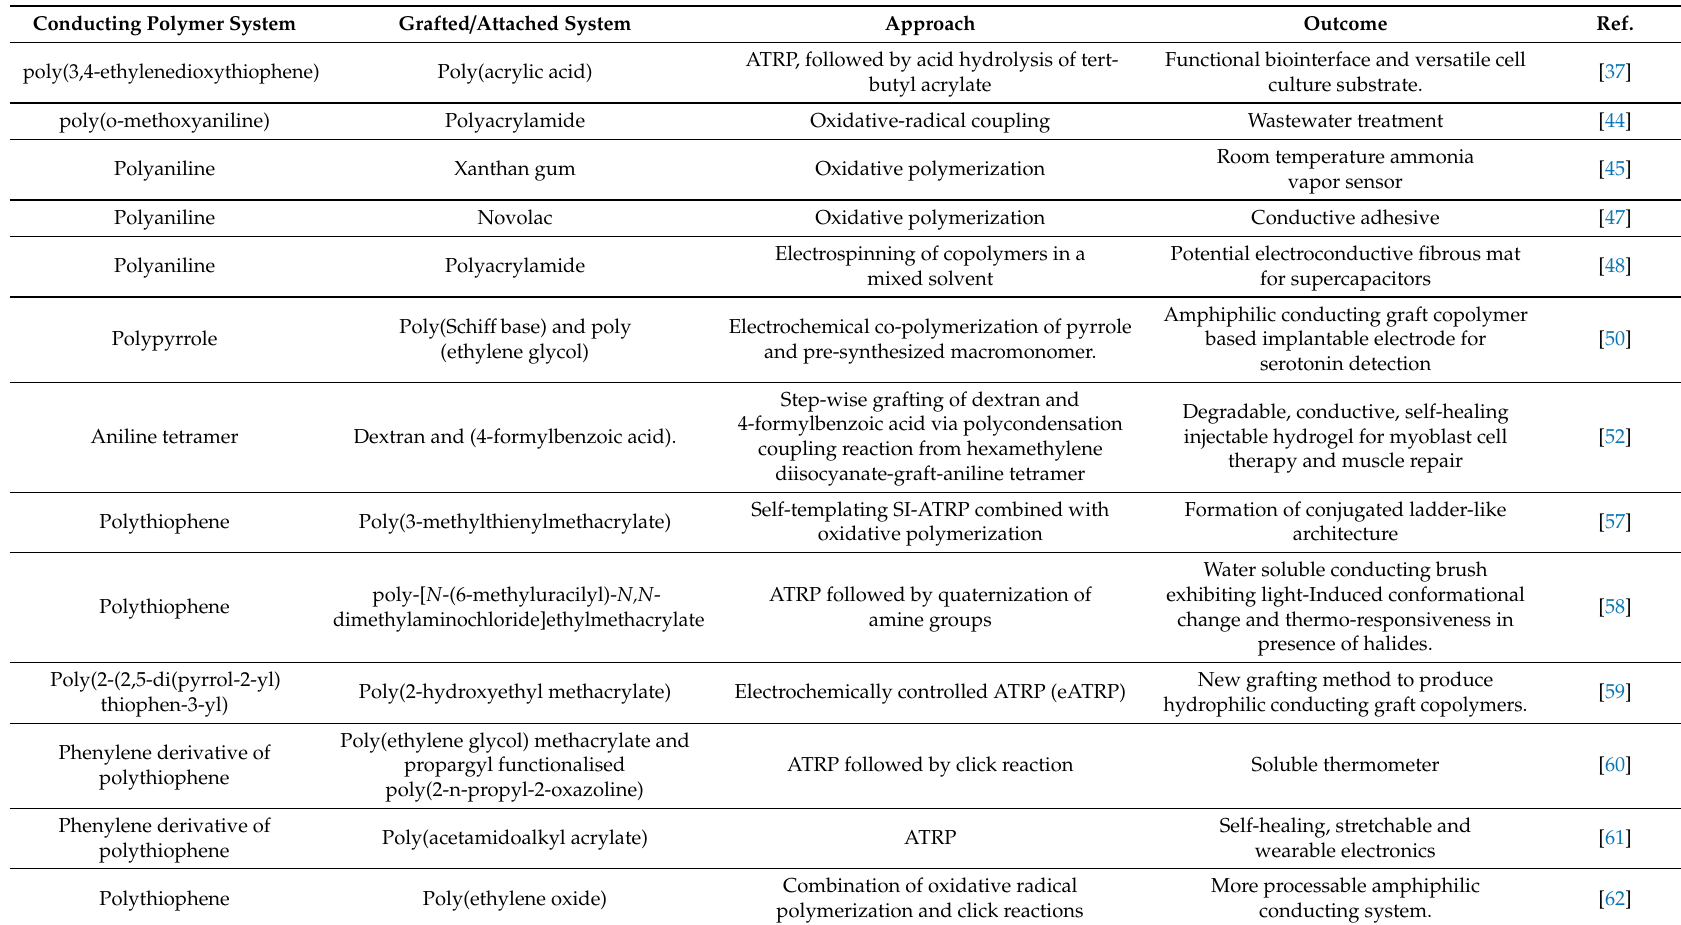
Table 1. Representative important research works done in the field of covalent grafting of conducting